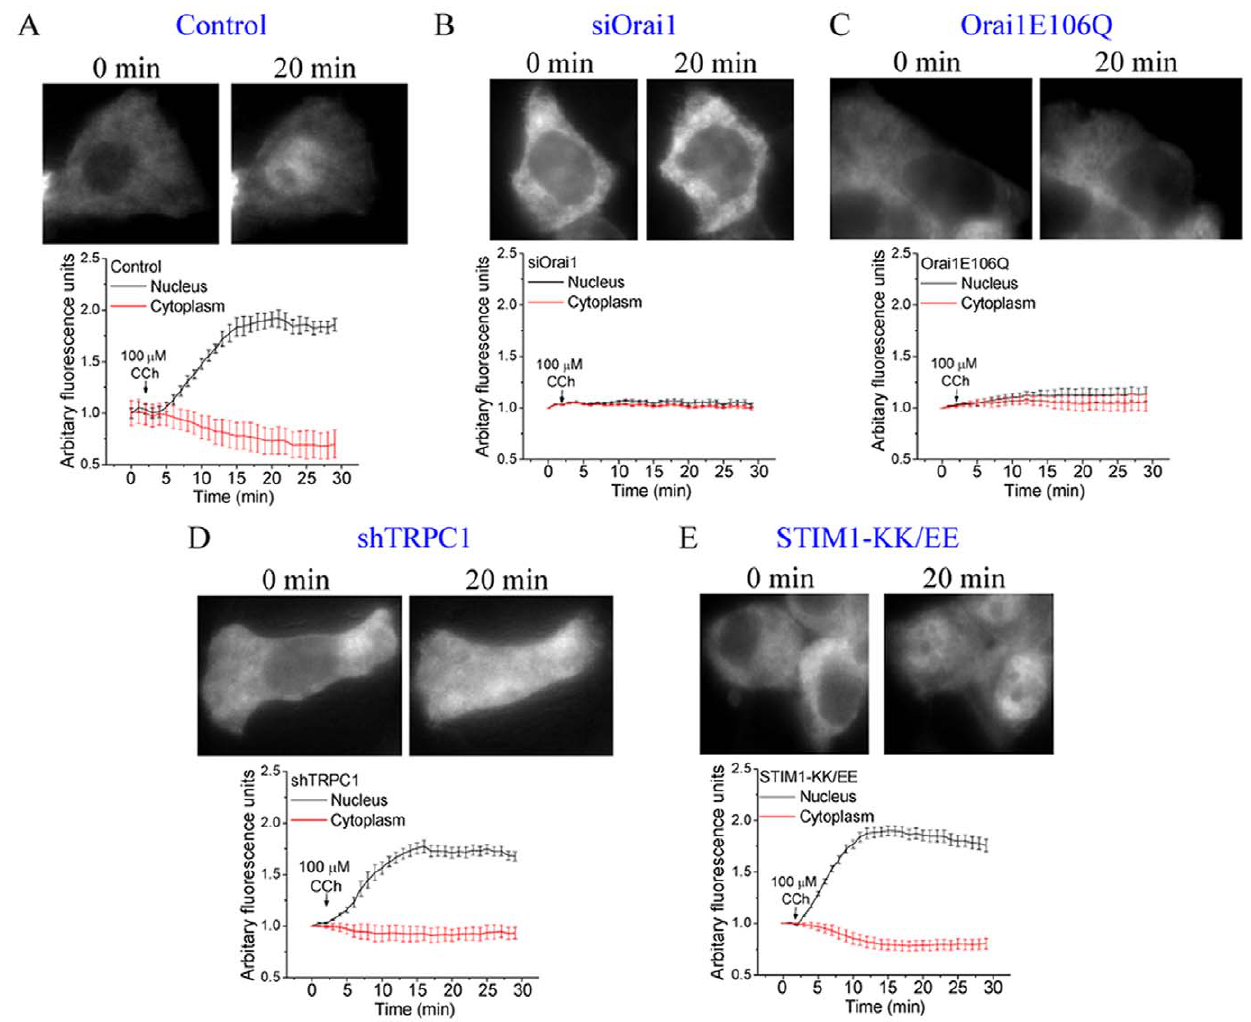
Figure 5. Effect of high [CCh] on NFAT nuclear translocation. Translocation of NFAT into the nucleus in control cells ( A ), and cells transfected with siOrai1 ( B ), Orai1E106Q ( C ), shTRPC1 ( D ) and STIM1EE ( E ). Traces show changes in GFP fluorescence intensities within the nucleus (black) and cytoplasm (red), following stimulation with 100 m M CCh. Each trace is representative of data obtained from at least 3 separate experiments ( $ 30 cells).